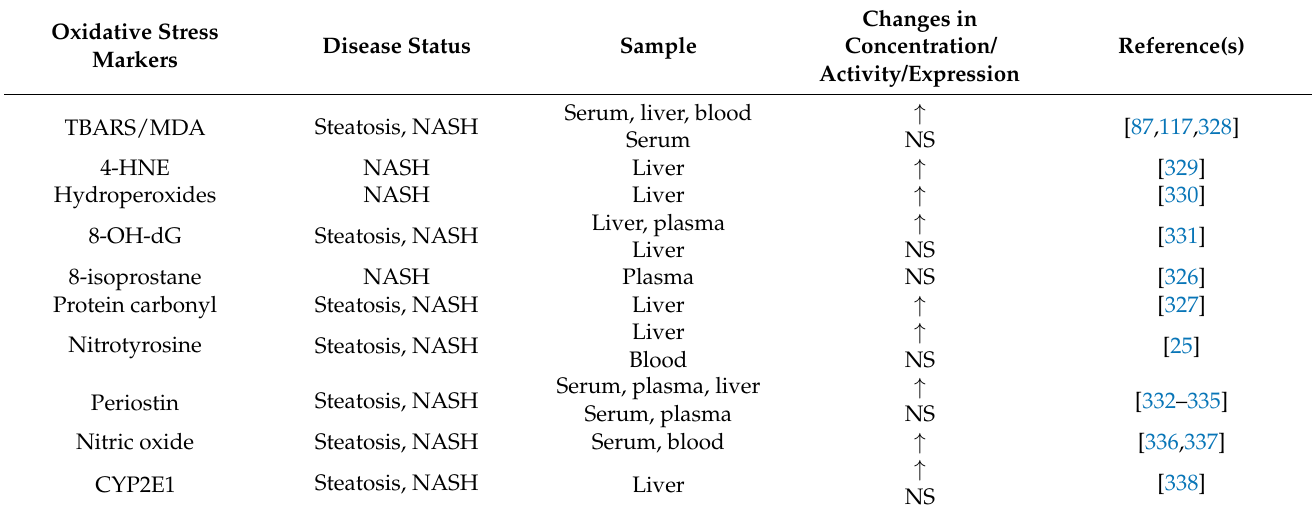
Table 2. Oxidative stress markers in NAFLD/NASH patients.